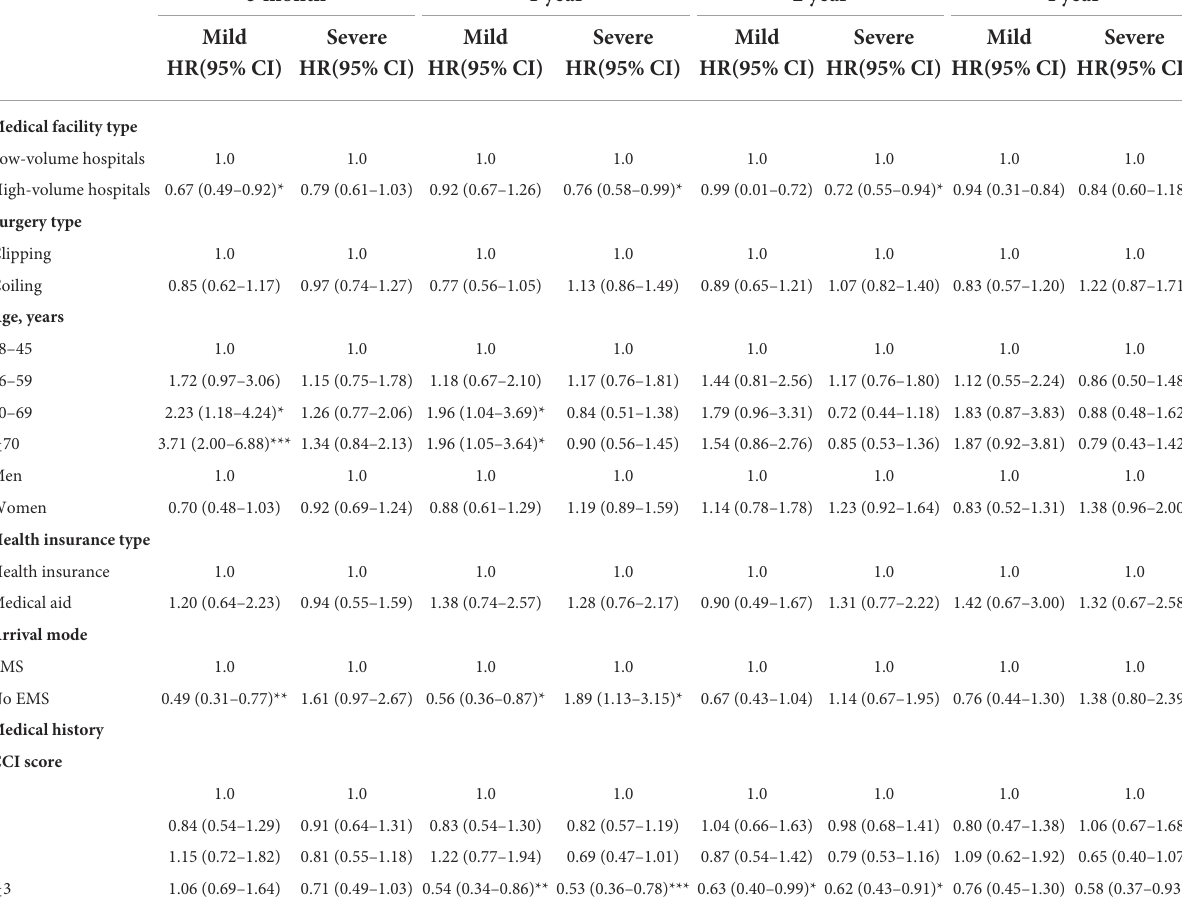
TABLE 2 Cox analysis of death according to severity in patients with subarachnoid hemorrhage for 4